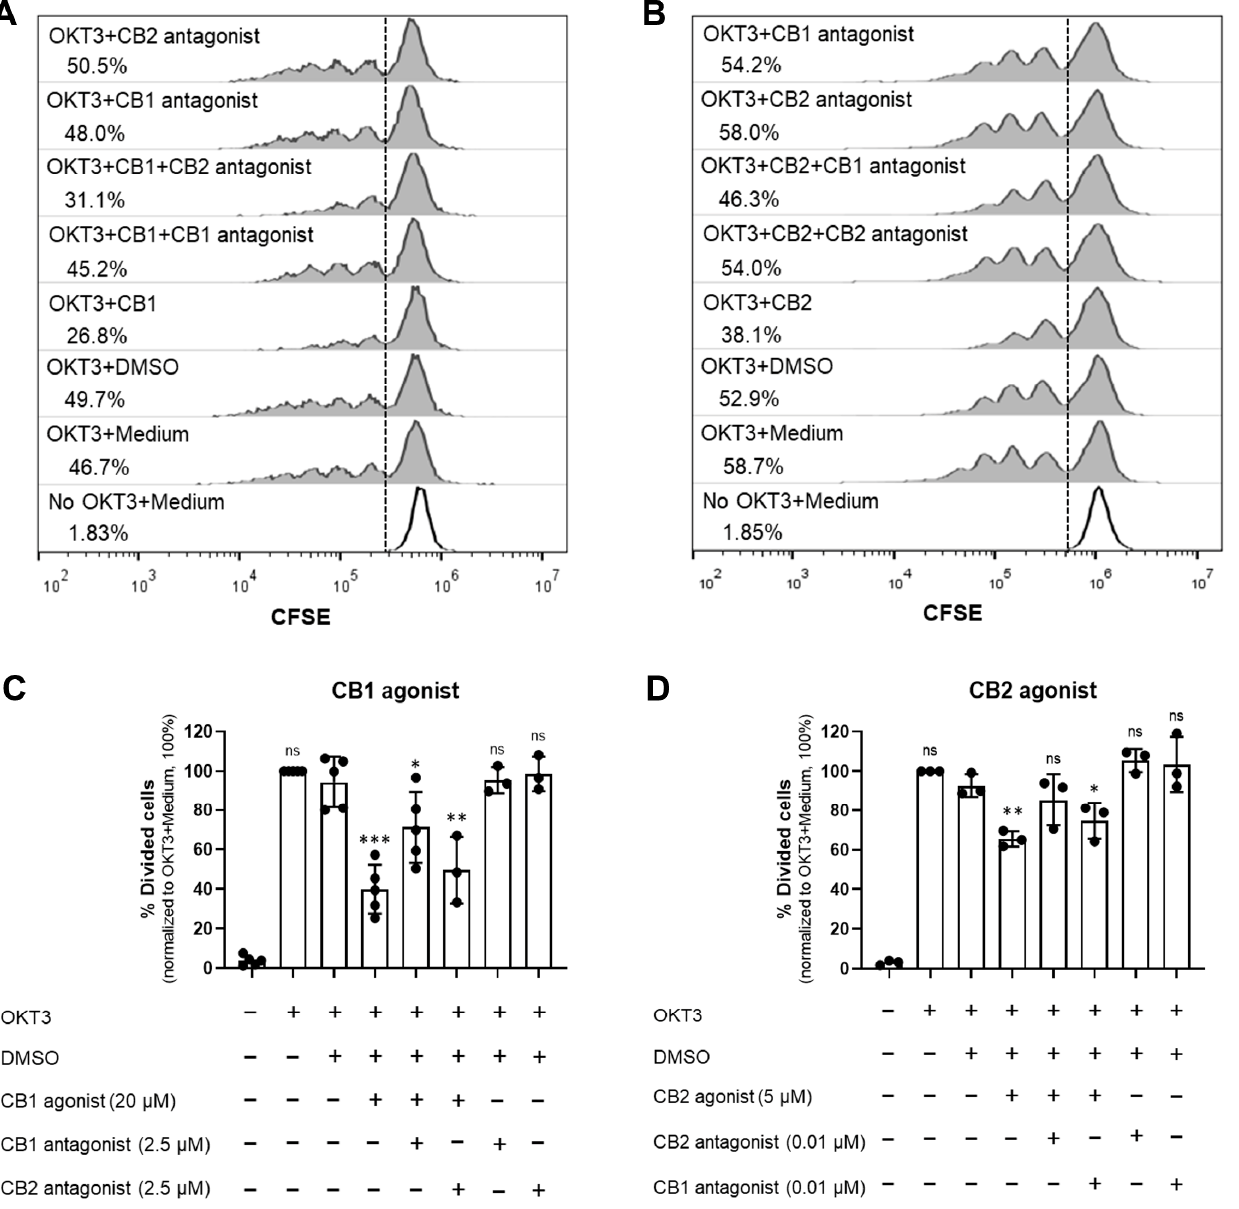
Figure 2. CB1 and CB2 agonists suppress T cell activation via their specific receptors. PBMCs were activated with anti-CD3 mAb (OKT3) or kept unstimulated (No OKT3) in the presence (+) or absence ( − ) of CB1 agonist (ACEA), CB2 agonist (GW833972A) or their antagonists (CB1 antagonist or CB2 antagonist) at the indicated concentrations or DMSO control (DMSO) at the relevant concentration for agonist plus antagonist. Histograms showing the percentage of divided cells in each condition provide the representative flow cytometric data of CB1 agonist ( A ) and CB2 agonist ( B ) treatment with their antagonists. The bar graphs show the percentage of divided cells under the indicated conditions of CB1 agonist treatment (n = 3 or n = 5) ( C ) and CB2 agonist treatment (n = 3) ( D ) as mean ± SD. A black dot represents individual datum. Each individual datum was normalized relative to its medium control (OKT3 + Medium) as 100%. We used unpaired t -test for comparison between DMSO control and each condition. * p < 0.05; ** p < 0.01; *** p < 0.001; ns = not statistically